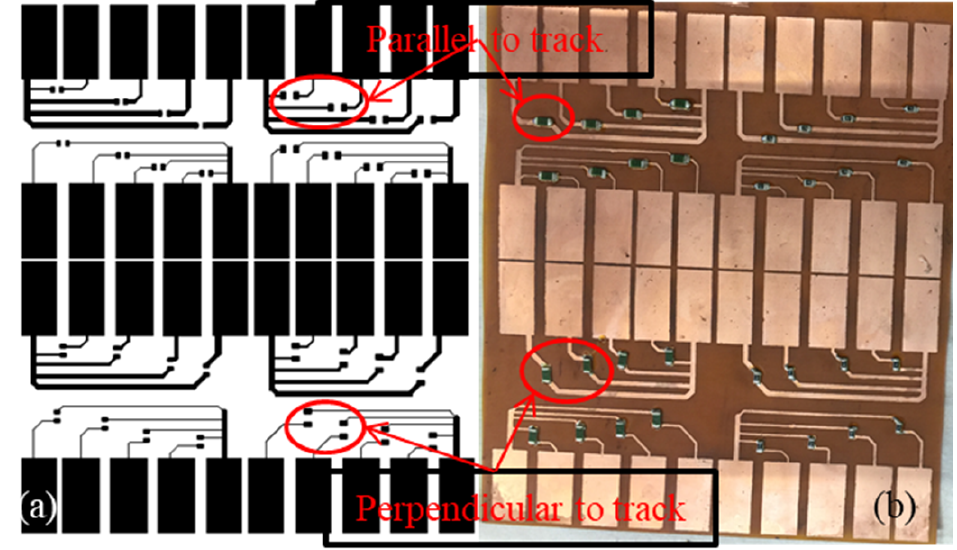
Figure 1. ( a ) Printed circuit design. ( b ) Photo of FPCB with soldered SMD